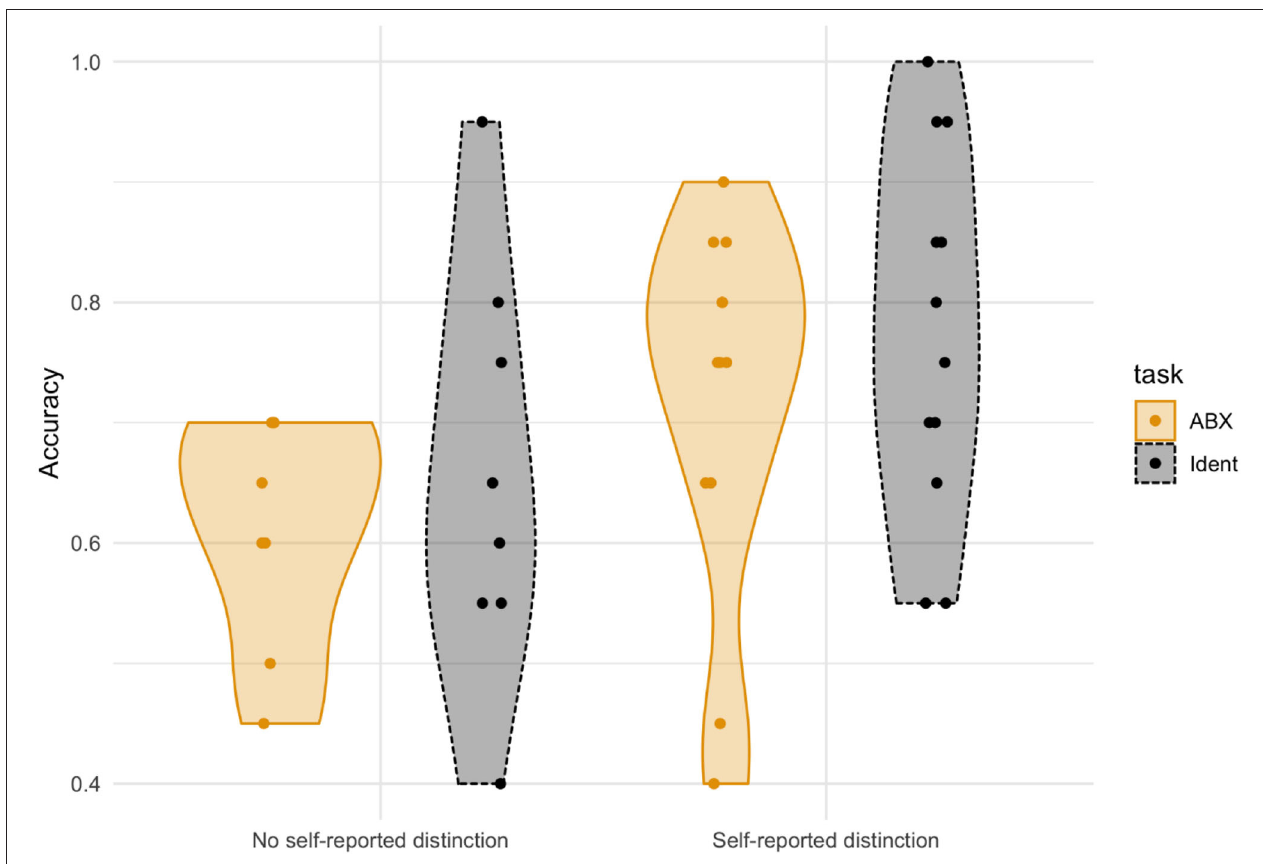
FIGURE 7 | Accuracy in perception by self-reported contrast for cot-caught. Accuracy in the two perception tasks (ABX and 2FC Identification), separated by self-reported distinction of caught-cot